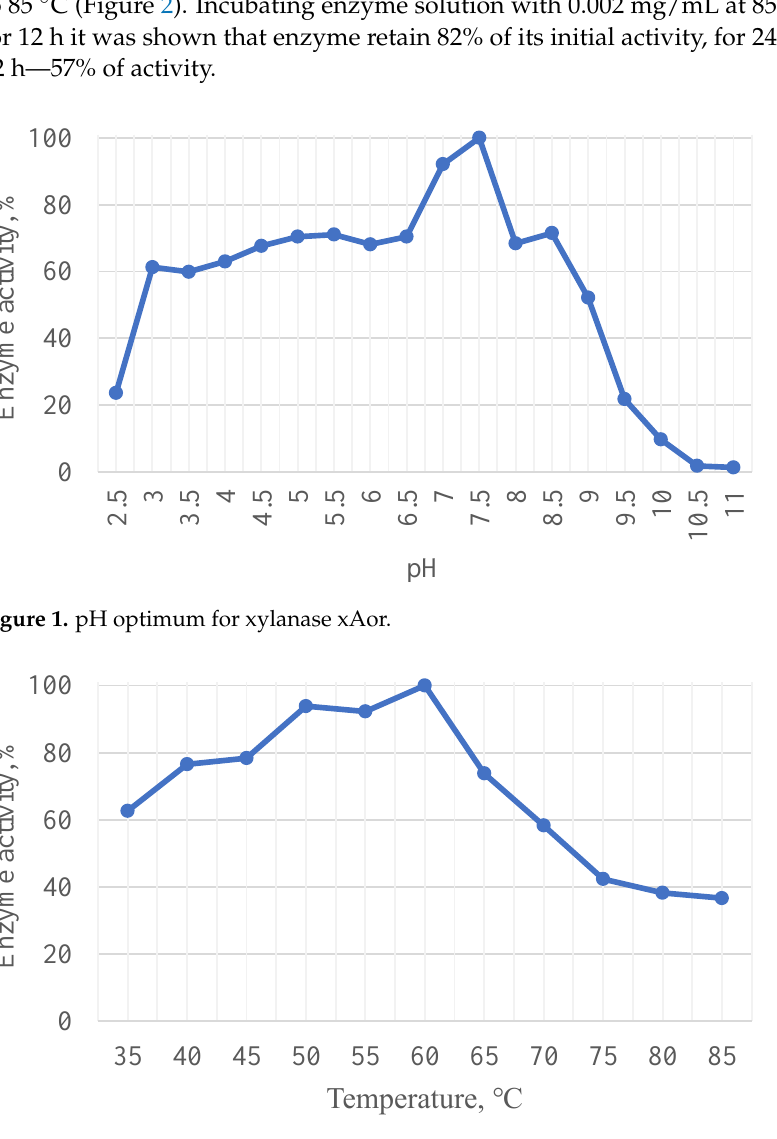
Figure 2. Temperature optimum for xylanase xAor.